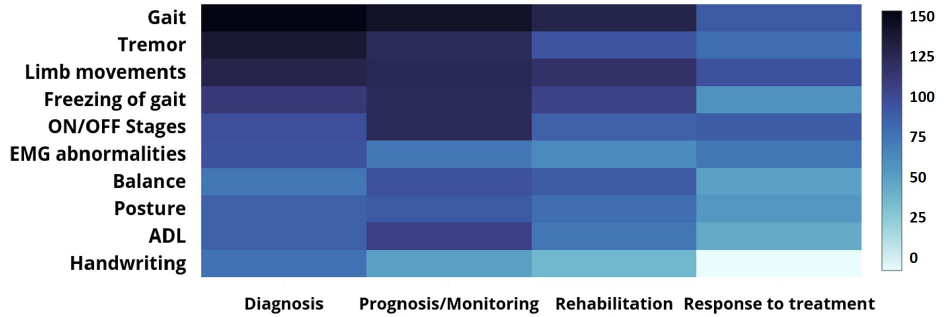
Figure 7. The heat-map presenting the number of research publications (2008–2021) that address the measuring of motor PD symptoms (the darker the color, the higher the